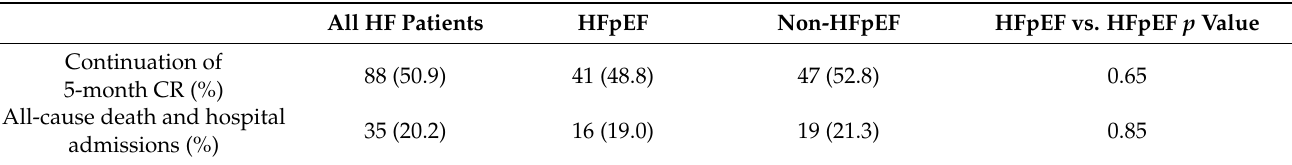
Table 2. Continuation of CR and all-cause death and hospital admissions in all HF patients and HFpEF and non- HFpEF